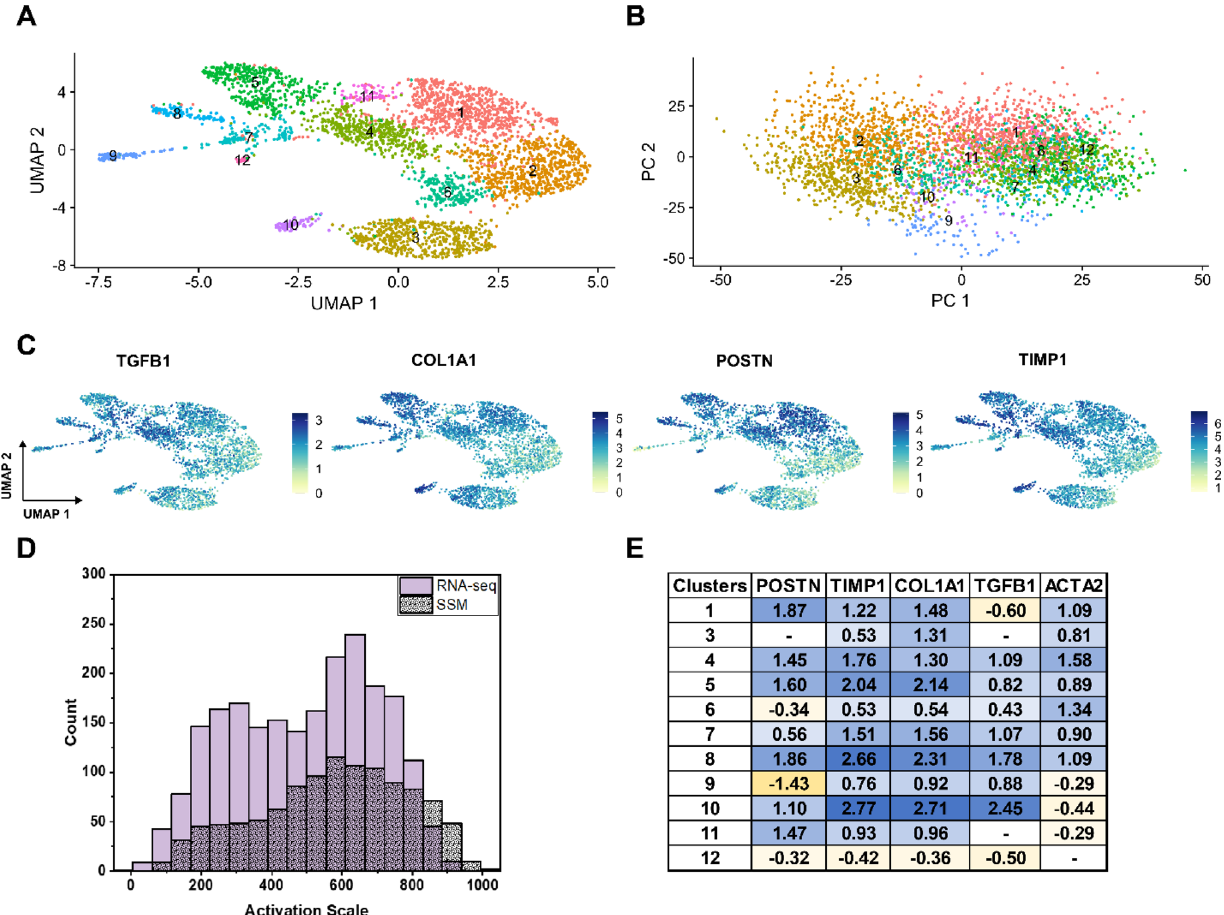
Figure 5. ( A ) UMAP reduction of the transcriptomic feature vector for each cell. Clusters were identified by the Suerat software. ( B ) PCA reduction of the transcriptomic features; individual cells are colored according to their cluster number from ( A ). ( C ) Labeling each cell by the expression level of four myofibroblast associated genes (TGFB1, COL1A1, POSTN, and TIMP1) shows a consistent spectrum of activation. ( D ) Using the PCA reduction, another continuous label system was created. The distribution of cells is similar to that seen from the SSM model. ( E ) Log 2 (FC) values of myofibroblast associated genes show that clusters 1, 4, 5, 7, 8, and 10 are highly activated compared to cluster